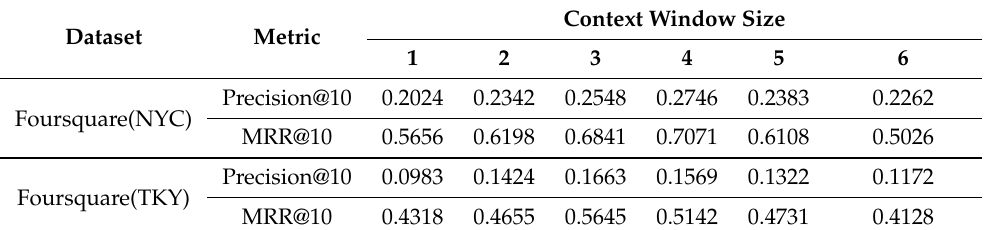
Table 2. Performance of different context window size on SG-FWARP (top-10 recommendations).